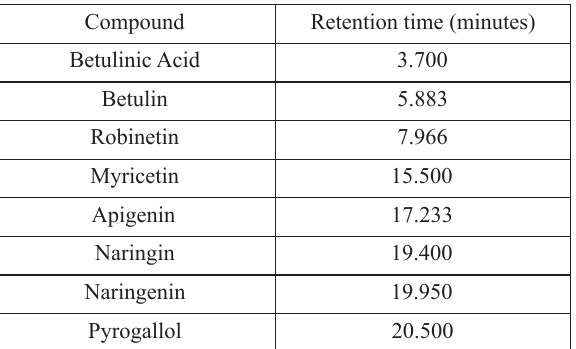
Identified alkaloids and flavonoids in fractionated